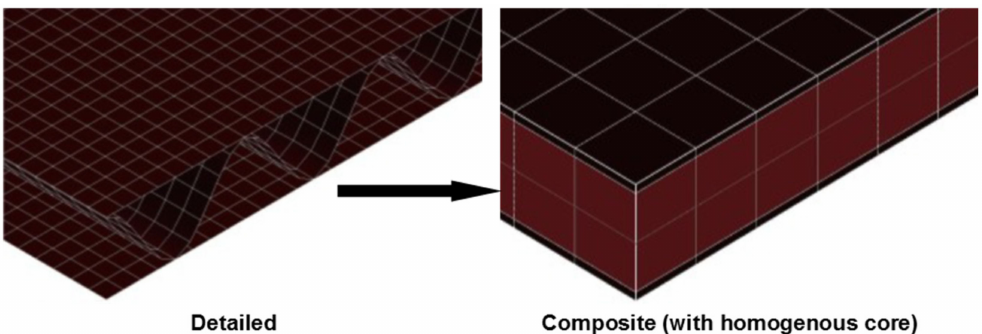
Figure 12. Illustrating the transition of corrugated core to an equivalent homogenized core [27]. Reprinted with